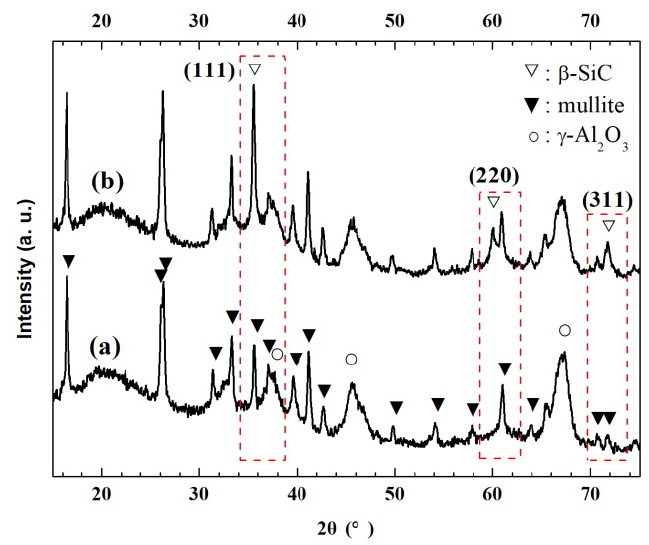
Figure 3. XRD patterns of the fibers without (a) and with (b) SiC coatings.